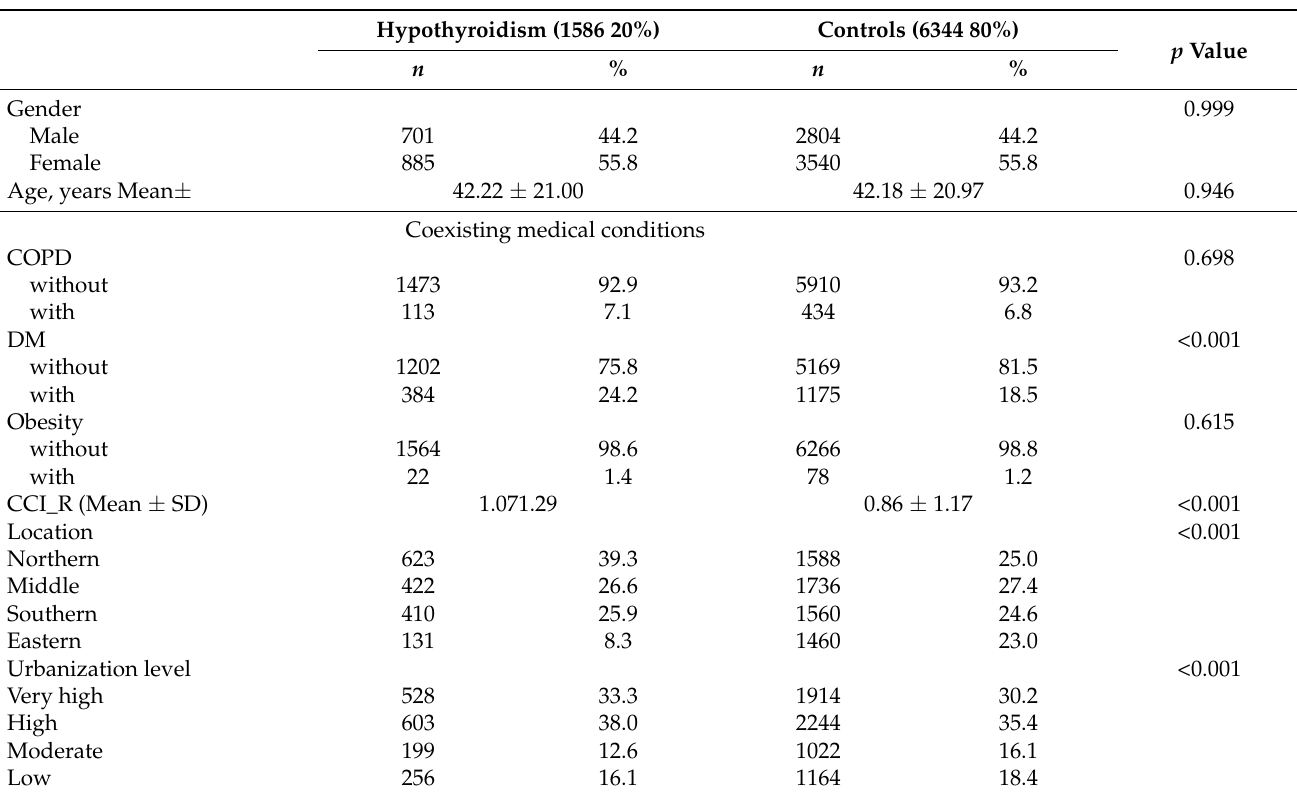
Table 1. Characteristics of study baseline (total